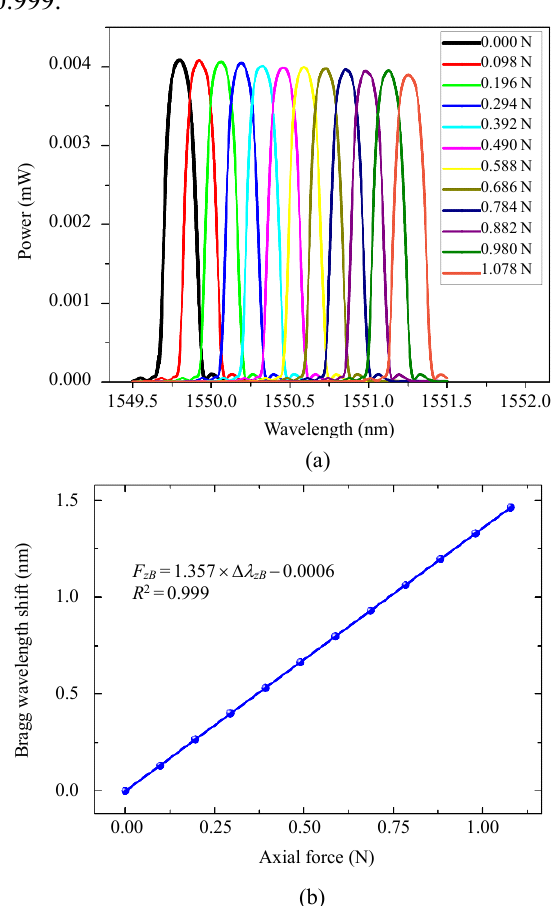
Fig. 2 Bragg wavelength of bare FBG shifts with the loaded axial force: (a) the measured FBG reflected spectra shifts with the change of the applied axial force F without wire and zB (b) the Bragg wavelength of FBG responses to the variation of the loaded axial force without